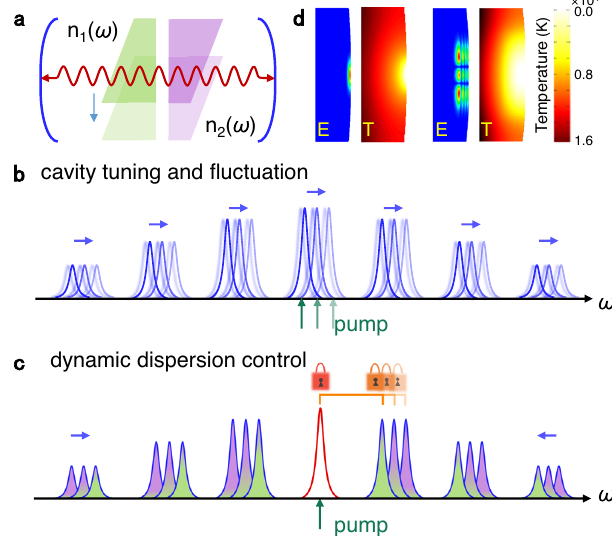
Fig. 1 | The principle of microsoliton stabilization and tuning by multiple global-frequency-tuning (GFT) methods. a Schematic of a cavity with two dielectric blocks made of different materials. The frequency of a selected reso- nancecouldbe fi xedbysimultaneouslycontrollingthefractionoftwoblocks,while the free-spectral range of the cavity could be changed due to different effective dispersions for two blocks. b The cavity spectral shift under a single GFT. The frequency of the pump laser should follow the resonance shift or fl uctuations to sustainastabilizedmicrosoliton. c ThecavityspectraundermultipleGFTmethods. The pump resonance is self-adaptively stabilized while the FSR can be tuned independently. d Thetwo-temperaturemodelinasilicamicrorod cavity.Whenthe cavity is excited by lasers through different spatial modes, the temperature shows distinct spatial distributions and thus induce different tuning effects to optical resonances, corresponding to the multiple GFT